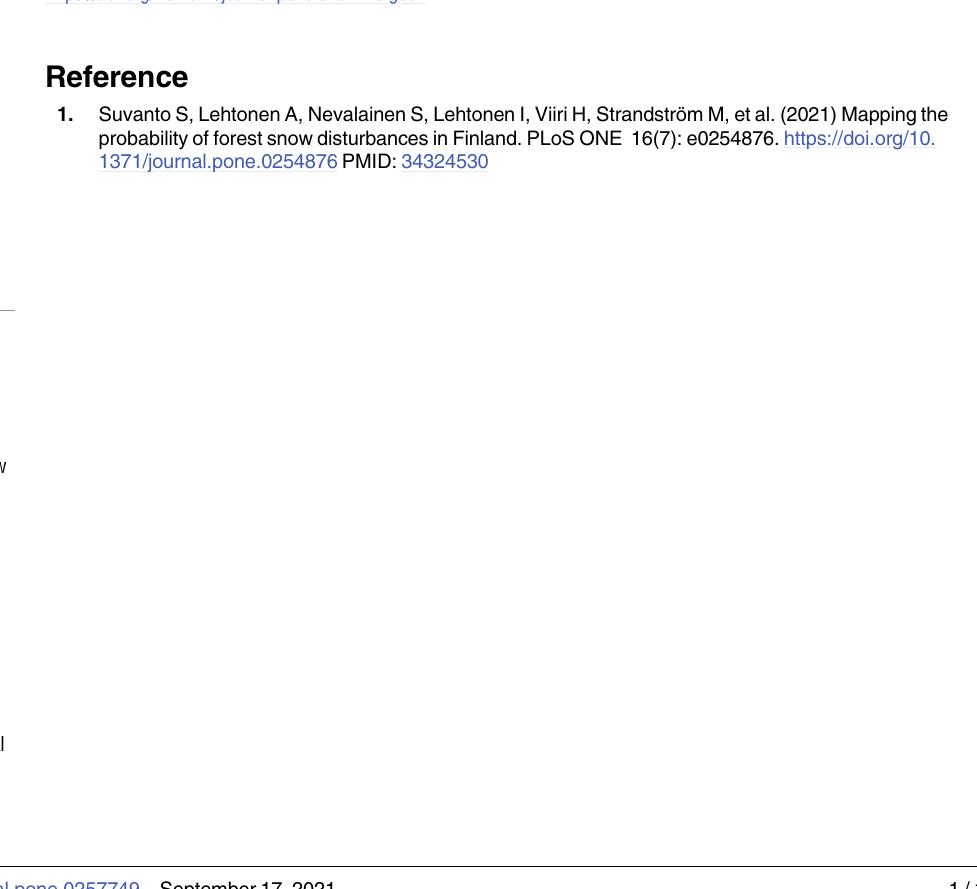
Fig 5. Cross-validation results for GLM and GAM with different predictor sets and for different time periods. Dash line shows the AUC = 0.7 threshold for acceptable level of discrimination between cases and non-cases.